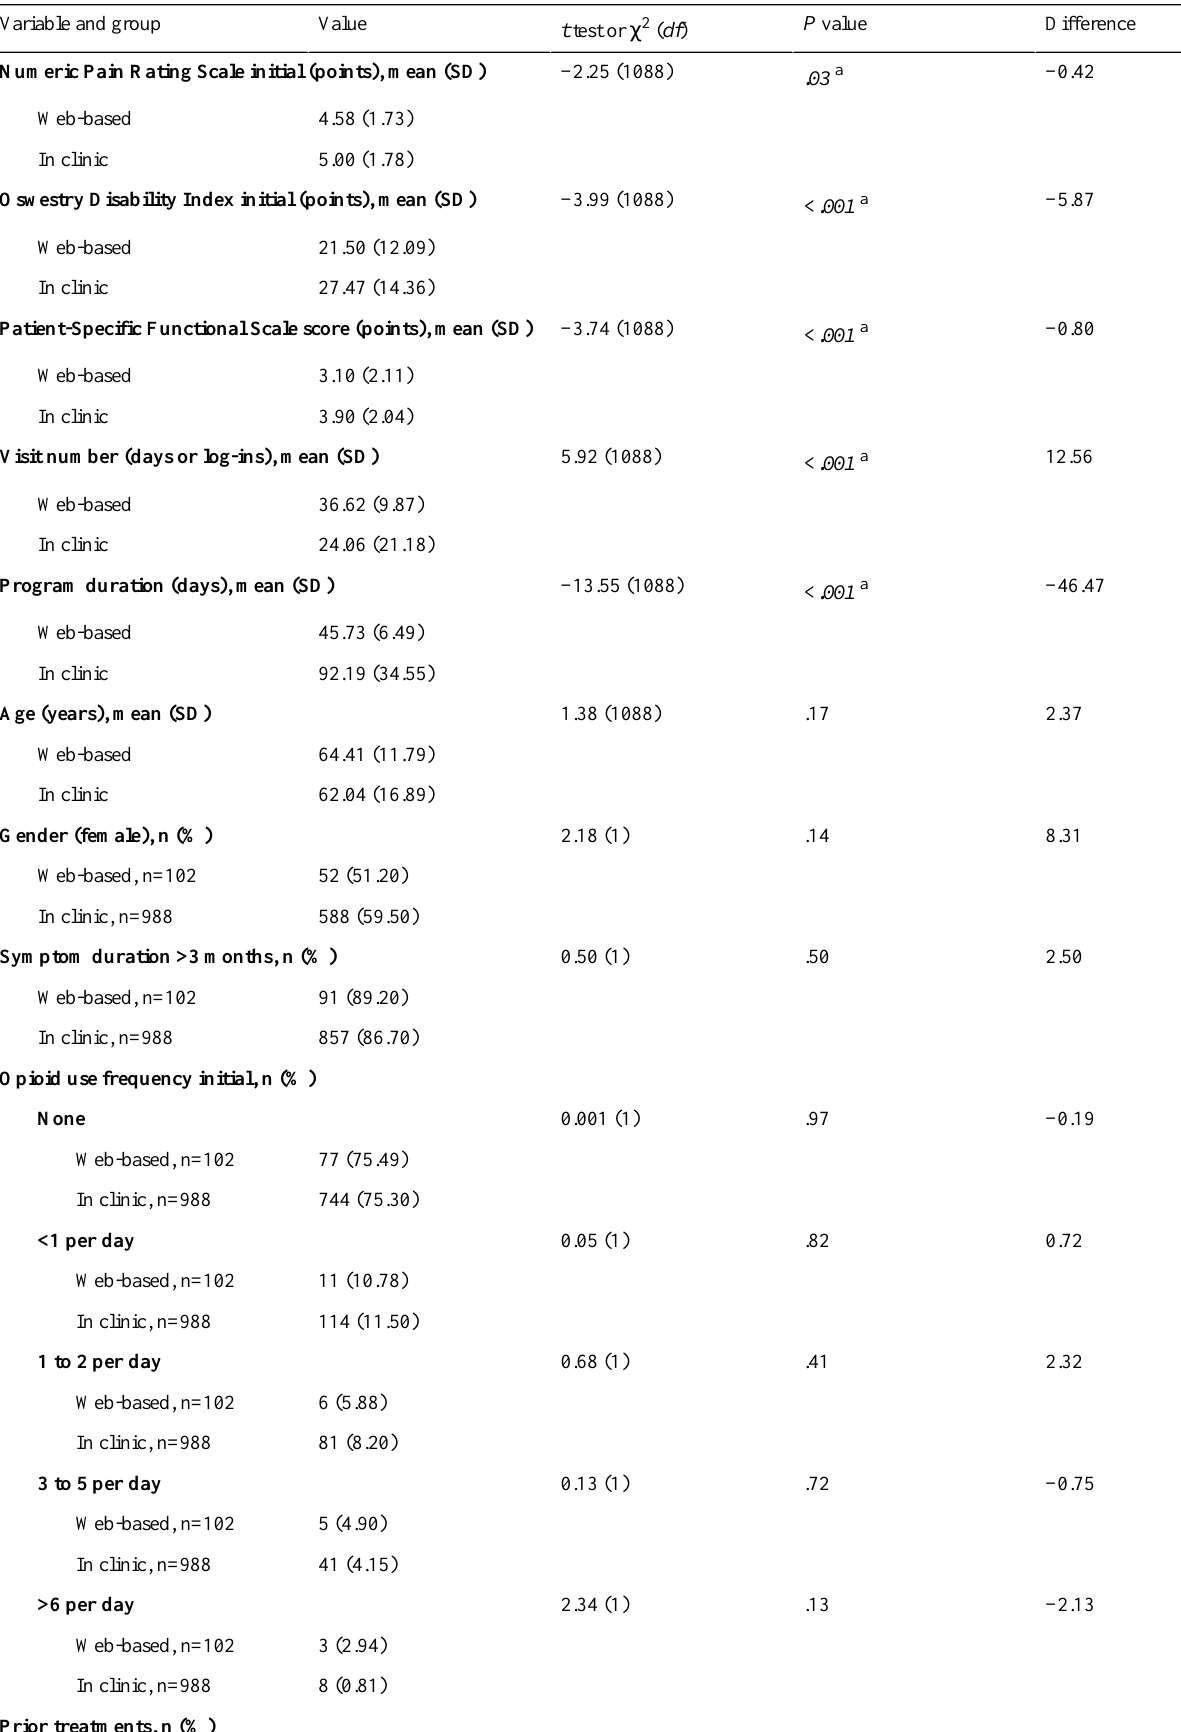
Table 1. Baseline characteristics between online integrated practice unit and in-clinic integrated practice unit